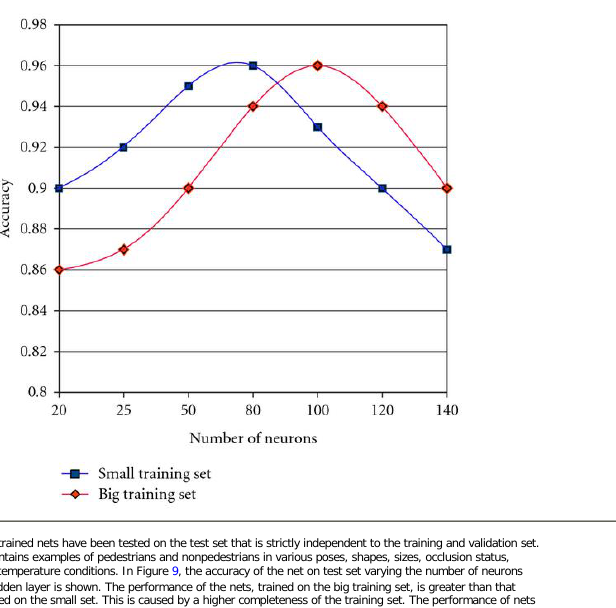
Figure 8 The accuracy of the net on validation set depending on the number of neurons in hidden layer. The optimal neurons number is a tradeoff between underfitting and overfitting.